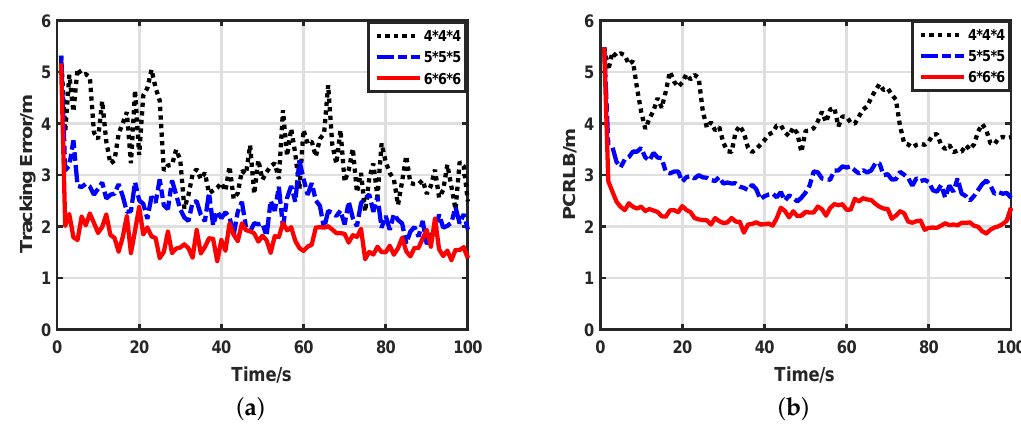
Figure 8. Target tracking performance of our scheme with 2-bit quantized measurements in different density networks. ( a ) Target tracking error with 2-bit quantized measurements; ( b ) posterior Cramer–Rao lower bound (PCRLB) with 2-bit quantized